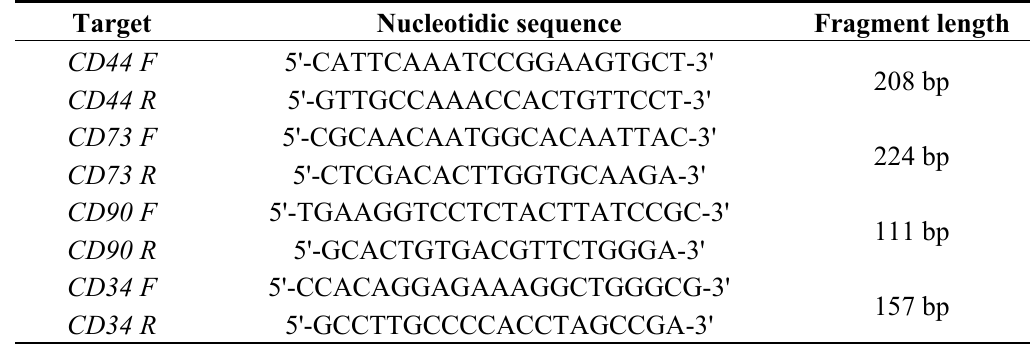
Table 3. Forward and reverse sequences of primers used to identify CD